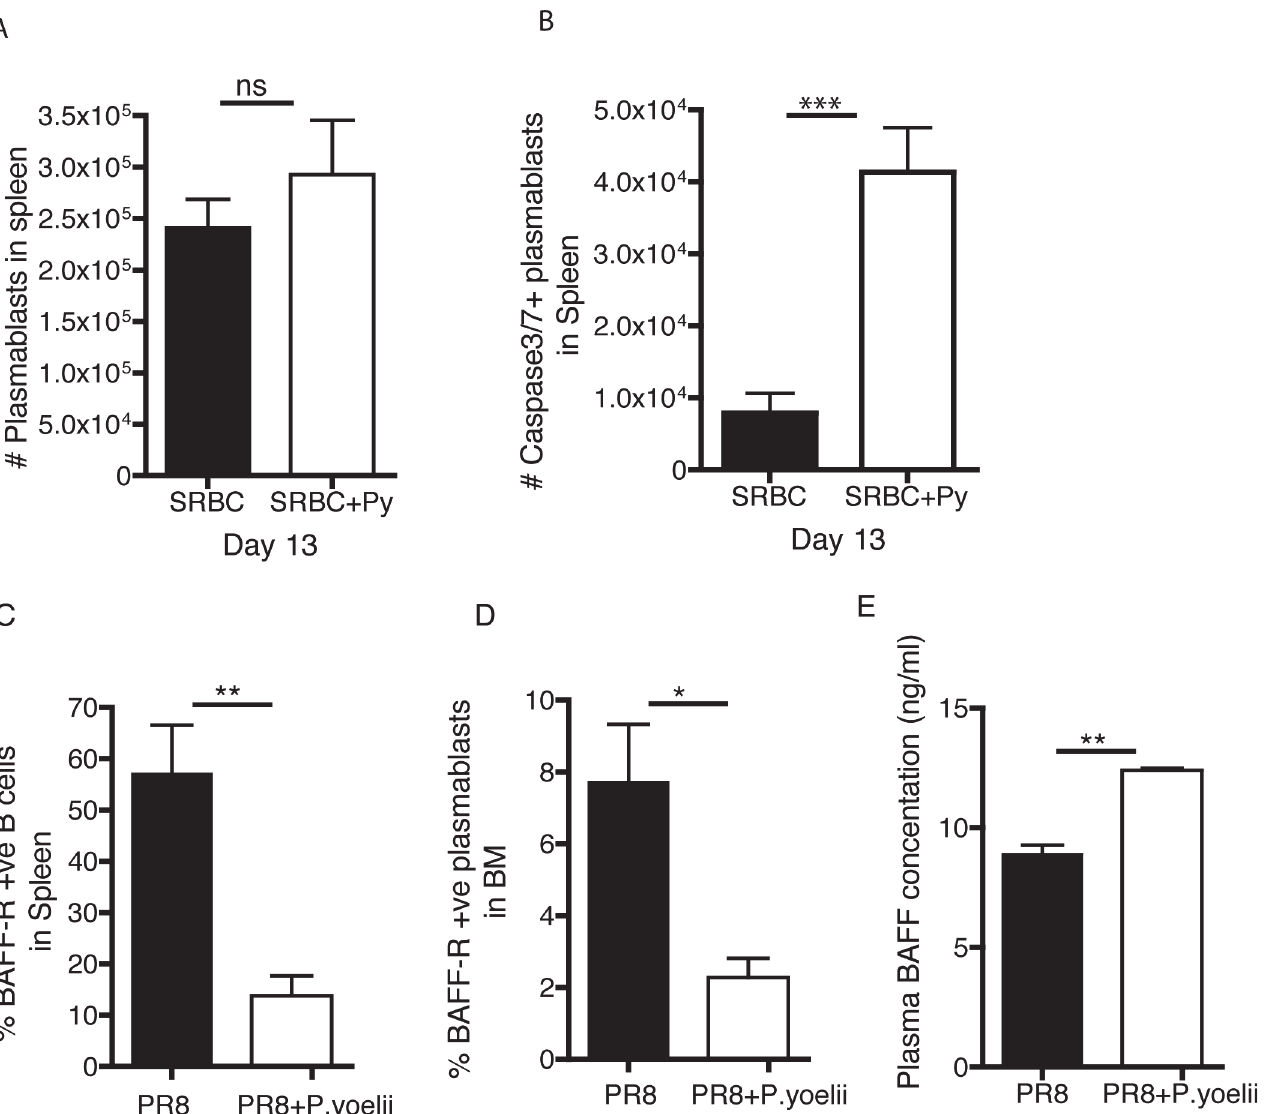
Fig 3. P . yoelii infection increases plasma cell apoptosis, decreases plasma cell BAFF-R and increases circulating BAFF concentrations. BALB/c mice were immunized with 10% SRBC suspension. Two days later, half of these mice were infected with 10 6 P . yoelii parasitized RBC while the other half of mice were injected with saline. (A) Total plasma cells in the spleen at day 13 post SRBC immunization. (B) Total caspase 3/7 positive plasma cells in the spleen at day 13 post SRBC immunization. Data in A,B are mean + S.D. and represent one of two independent experiments with 5 mice per group. Swiss Webster mice were infected with a sublethal dose of PR8. Forty-two days later, half of these mice were infected with 10 6 P . yoelii parasitized RBC. The percent of BAFF-R positive plasma cells in the (C) spleen and (D) bone marrow were determined on day forty-eight after immunization (day 6 after Py infection). Serum was obtained from mice in C,D and analyzed for circulating BAFF concentrations (E). Data in C-E reflect mean + S.D. and represent one of two independent experiments with 5 mice per group. *** p < 0.001, ** p < 0.01, * p < 0.05, ns p